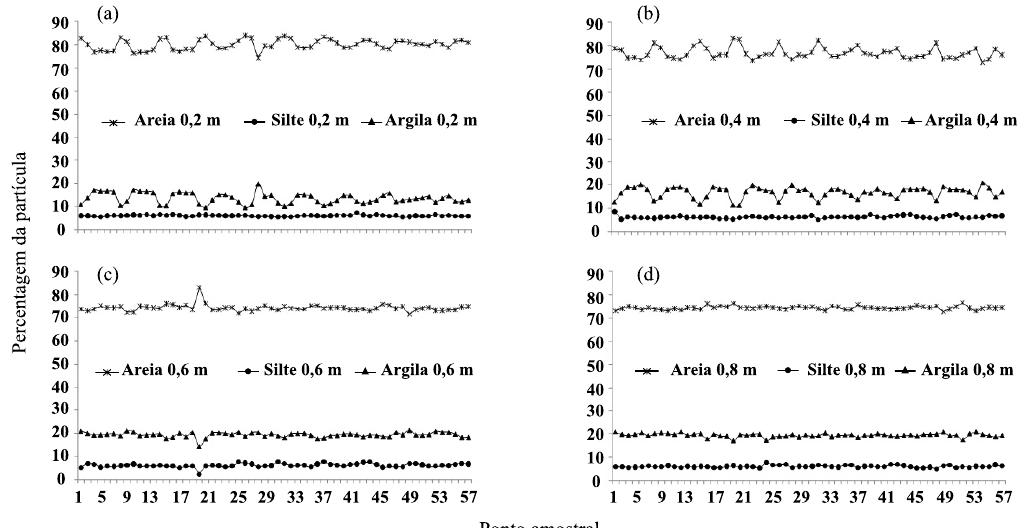
Figura 3. Percentagem de areia, silte e argila nas profundidades de 0,2 m (a), 0,4 m (b), 0,6 m (c) e 0,8 m (d), nos 60 locais